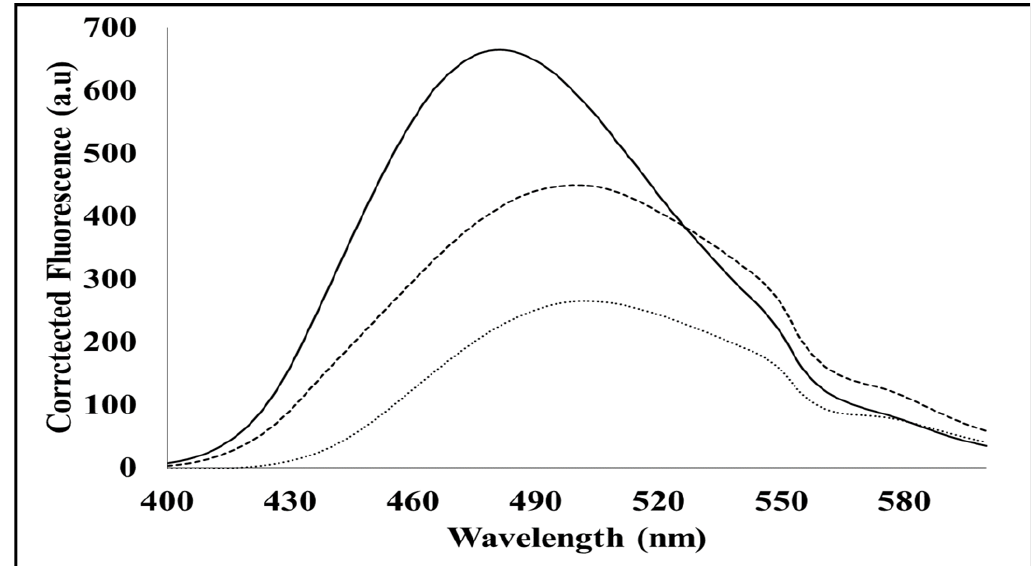
Figure 4. A spectrum showing extrinsic ANS fluorescence. Spectra of 200 µM ANS (star dashes) bound to 10 µm SACMV MP (solid line) and 8 M urea + 10 µM MP (dashes).